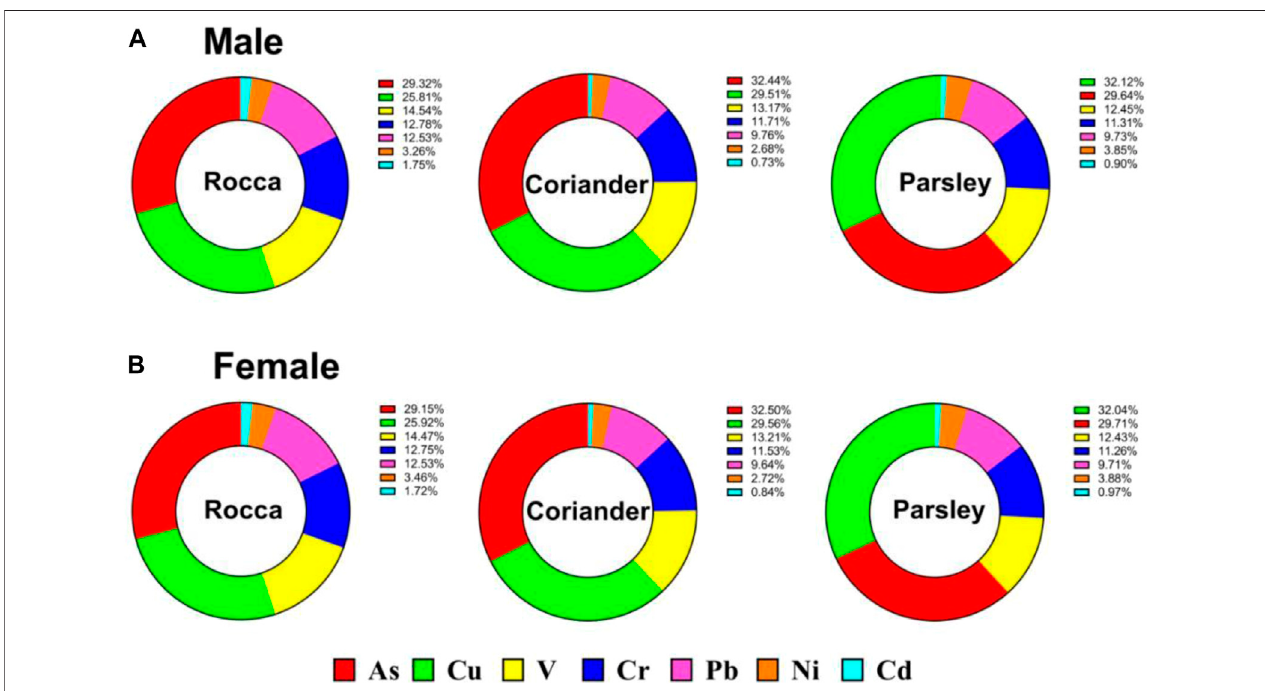
FIGURE 3 | Comparison of health risks caused by the different metal(oid)s according to HI among adult population. (A) Men and (B) women.